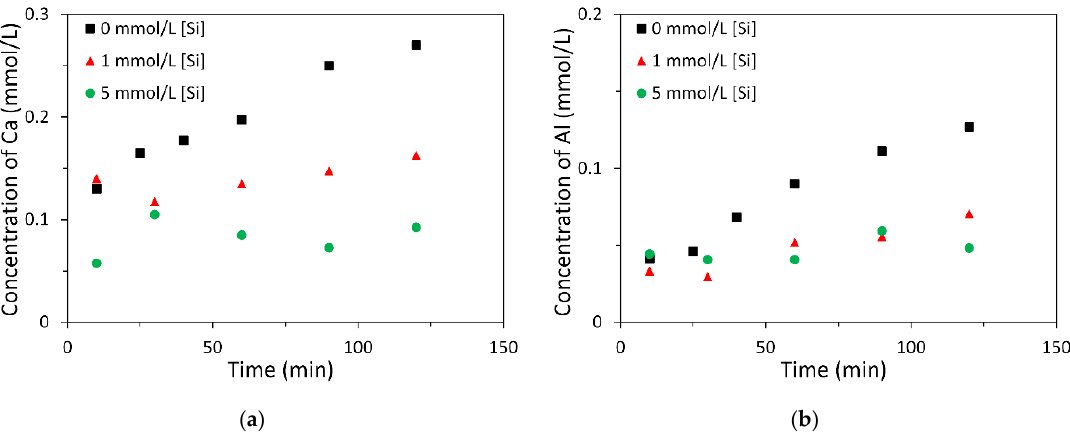
Figure 8. Measured concentrations of Ca ( a ) and Al ( b ) for the dissolution of slag in 0.1 mol / L sodium hydroxide solution with and without soluble Si.